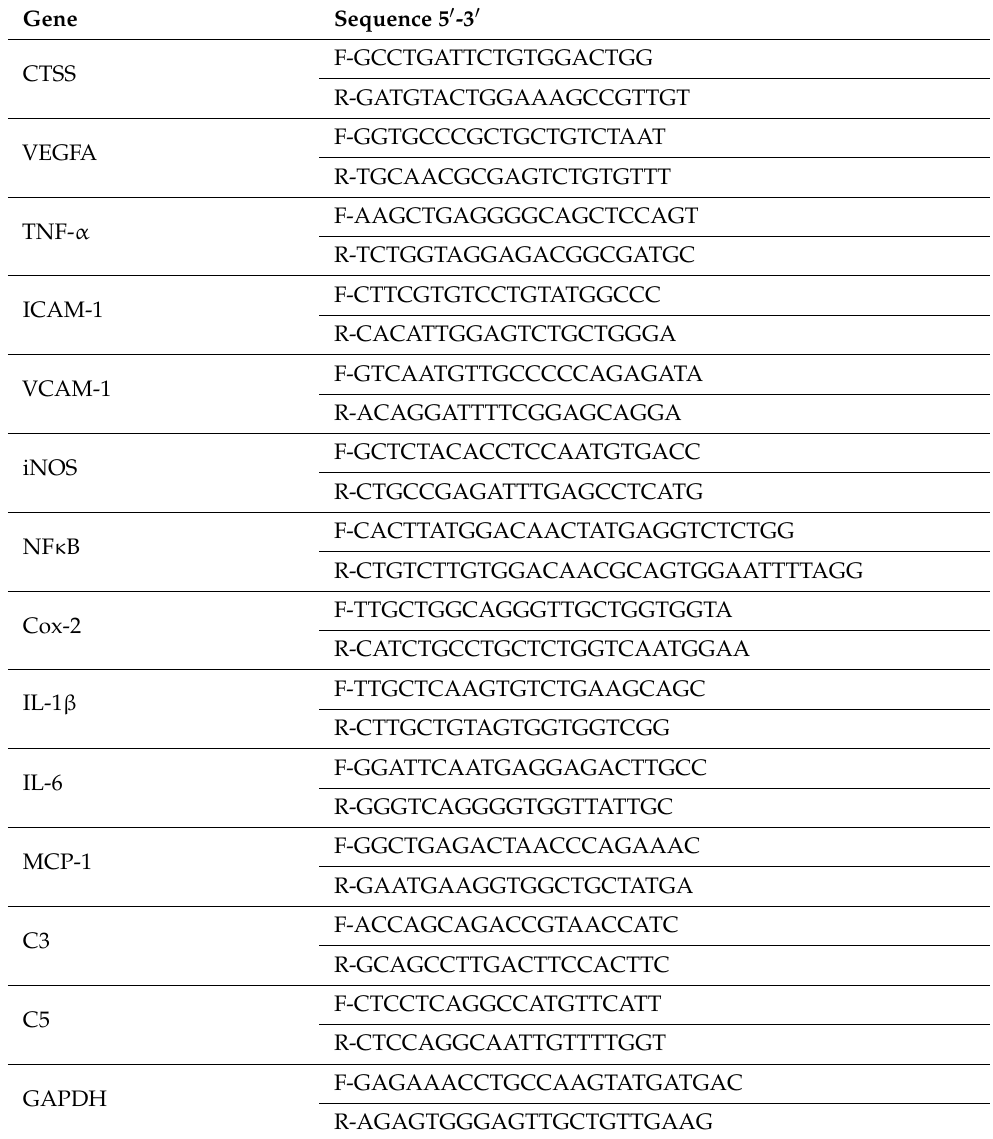
Table 1. qRT-PCR primer sequences used in this